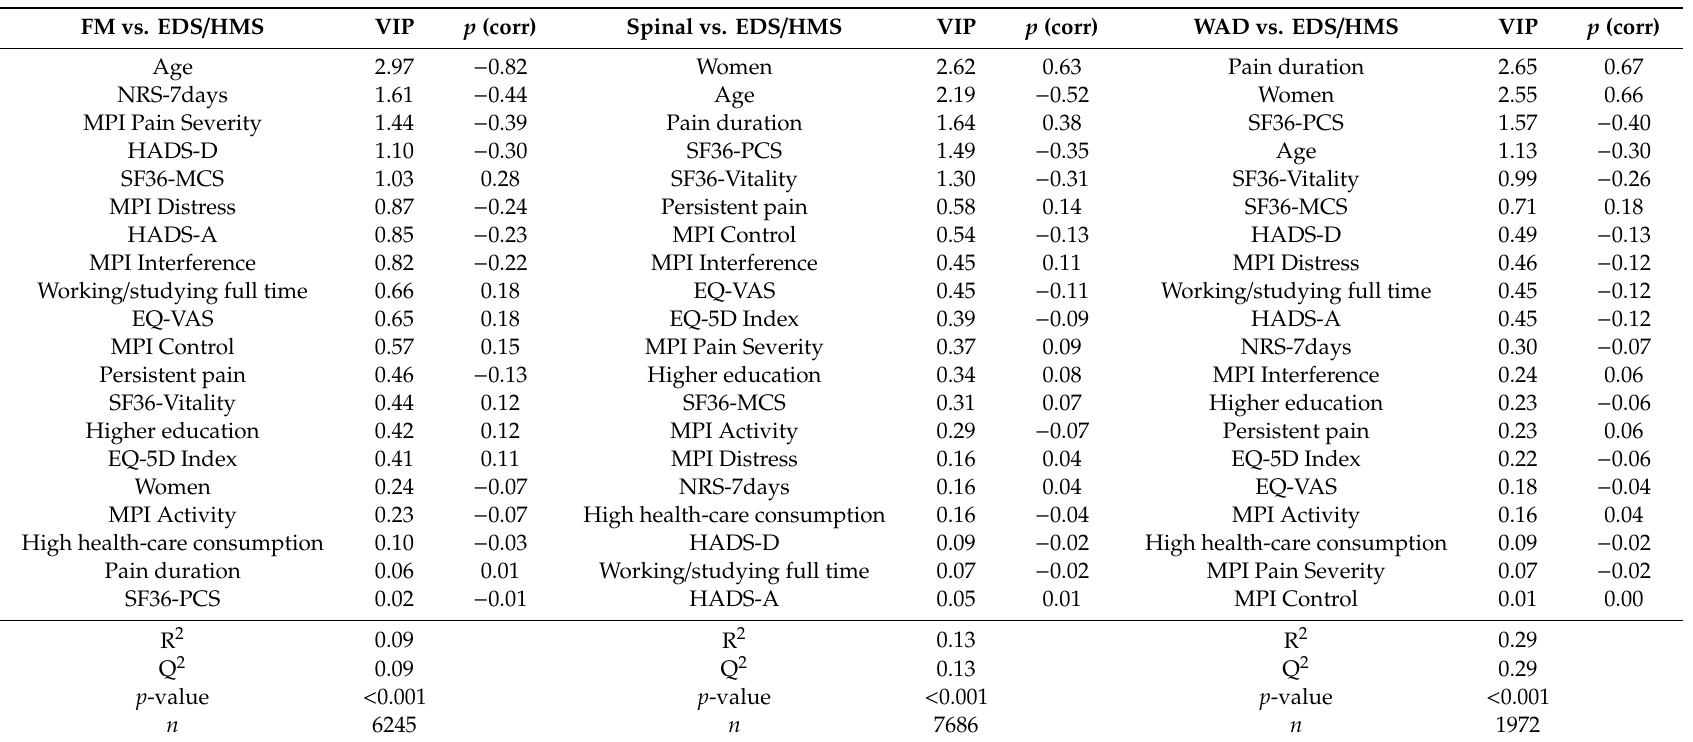
Table 5. OPLS-DA regressions di ff erentiating EDS / HMS from FM, spinal pain, and WAD, respectively. Variables in bold type are significant. FM vs. EDS /